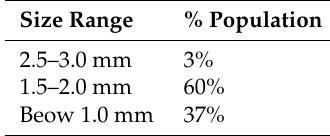
Table 1. Size ranges of substrate